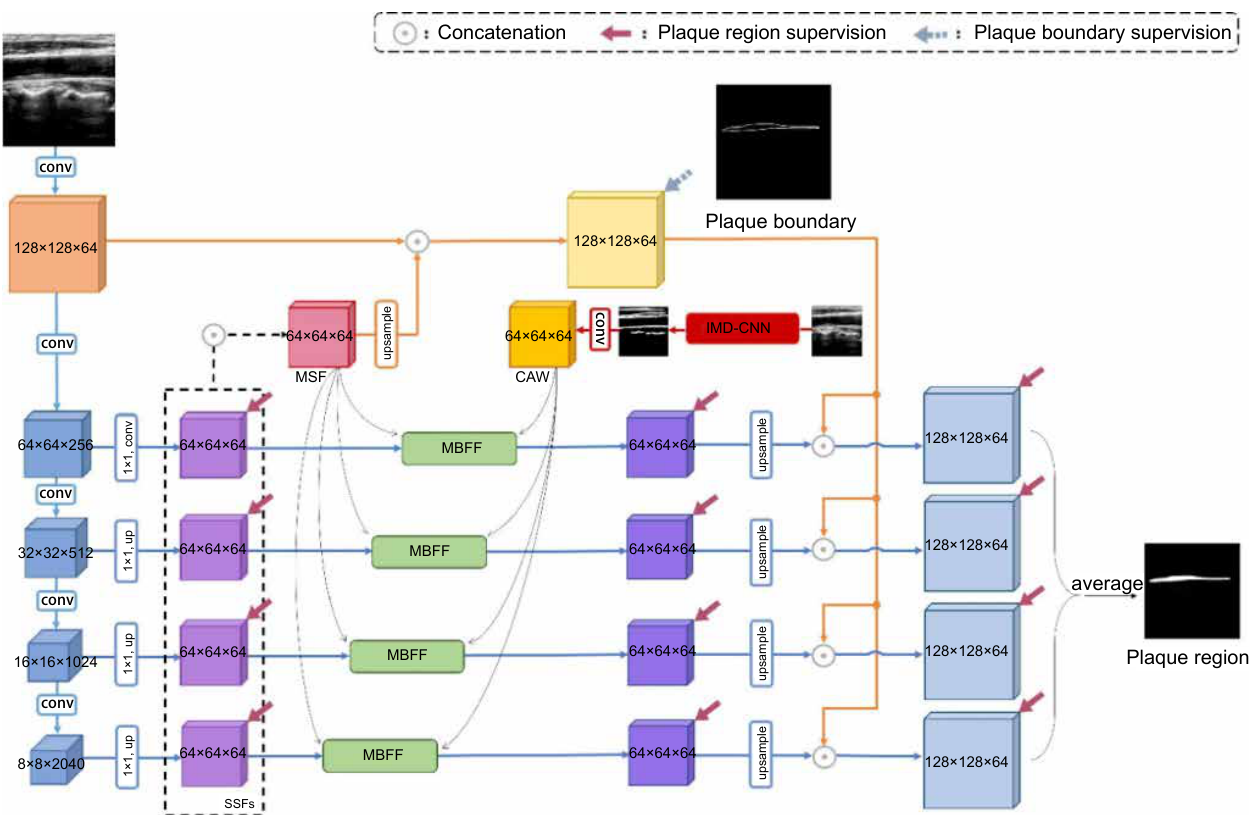
Figure 6 MBFF-Net Outlines the framework, where the orange line represents the boundary holding structure, the red line represents the extraction process of CAW, and the blue line represents the extraction process of plaque